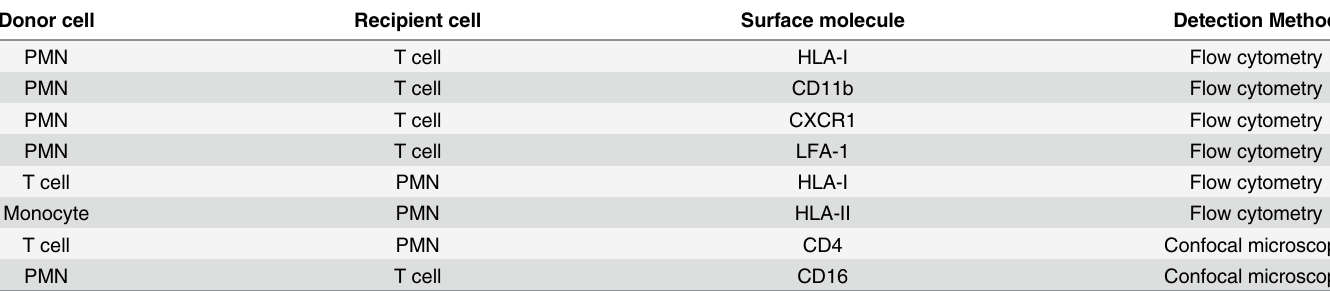
Table 3. Specific surface molecule transfer among PMN, T cells and monocytes.